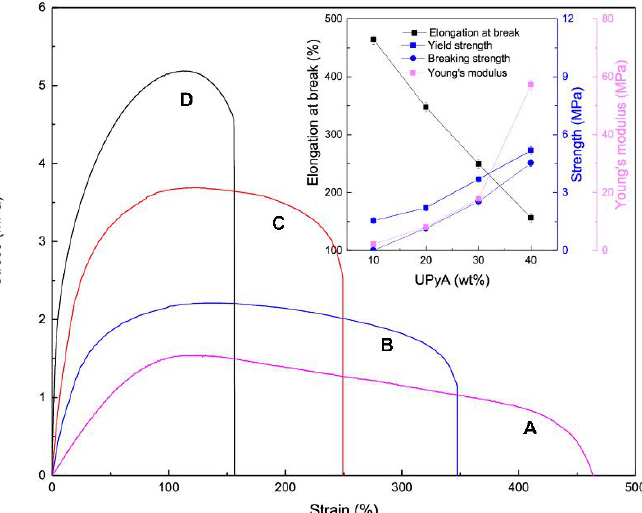
Figure 9. Stress-strain curves and analysis of elongation at break changes with the content of UPy for ( A ) DDSQ[P(BA- co -UPyA10] 2 , ( B ) DDSQ[P(BA- co -UPyA20] 2 , ( C ) DDSQ[P(BA- co -UPyA30] 2 and ( D ) DDSQ[P(BA- co -UPyA40] 2 . Reprinted with permission from ACS Appl. Polym. Mater . 2020, 2 , 3327 – 3338. [72] Copyright (2020) American Chemical Society.